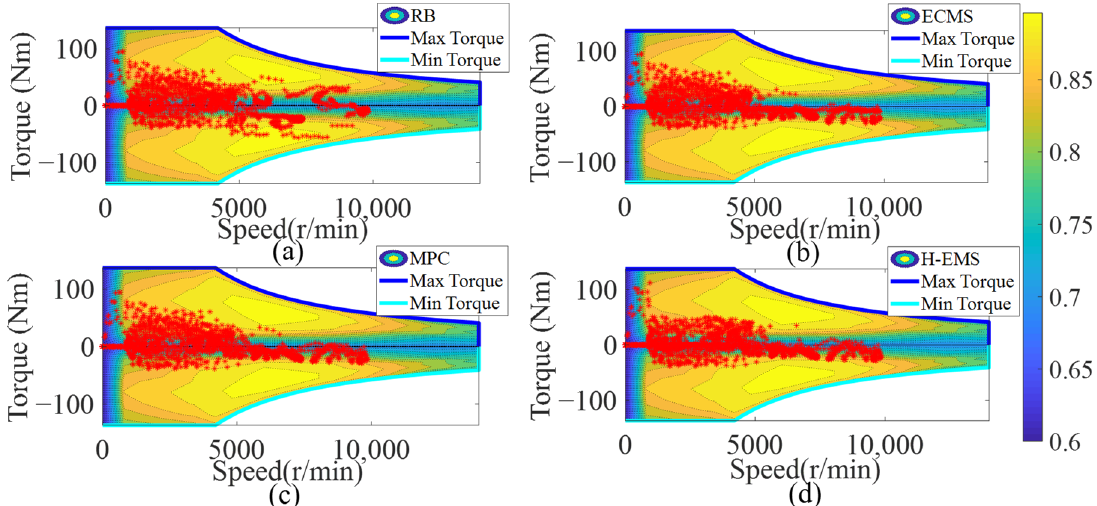
Figure 13. Front motor operating points of energy management strategies. ( a ) RB strategy; ( b ) ECMS strategy; ( c ) MPC strategy; ( d ) H-EMS strategy.